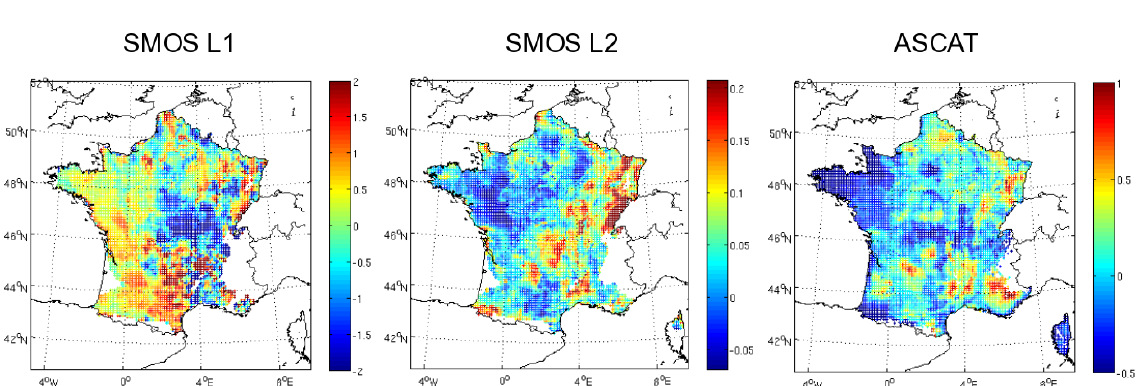
Fig. 9. Residual term of the regression equation of (left) SMOS-L1 F, (centre) SMOS-L2 B 0 , (right) B * intercepts vs. altitude ( Z ).